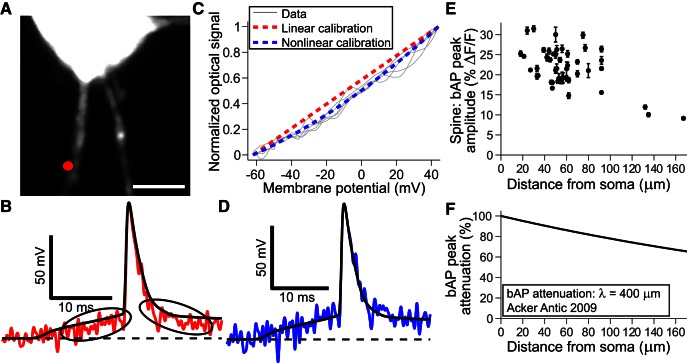
Calibration of the voltage dependence of spine ΔF/F using optical recordings in spines of bAPs. A, Image of neuron loaded with VSD and a region of basal dendrites. Red dot shows juxtasomatic basal dendrite recording location. Scale bar, 5 μm. B, Superimposed electrical action potential and optical bAP recordings (average of N = 8 sweeps) from juxtasomatic site showing reduced optical sensitivity at subthreshold potentials (circled). Peak optical sensitivity = 13.8% ΔF/F; 200 pA, 50 ms current injection. C, Binning and plotting optical (peak normalized) versus electrical data shows nonlinear voltage-dependent VSD sensitivity (N = 5 trials, gray lines). Blue dashed line shows quadratic fit to sensitivity data, whereas red dashed line (shown for comparison) represents a linear relationship between rest and the peak of the AP. D, Adjusting the optical data with nonlinear sensitivity calibration from C demonstrates accuracy in both subthreshold and superthreshold potential ranges. E, Amplitude of the optical bAP in the spine (percentage ΔF/F) versus distance from soma for N = 48 spines across 32 different cells. F, Attenuation of bAPs as a function of distance from soma in basal dendrites of L5 pyramidal neurons as previously reported using a VSD (length constant λ = 400 μm; Acker and Antic, 2009).